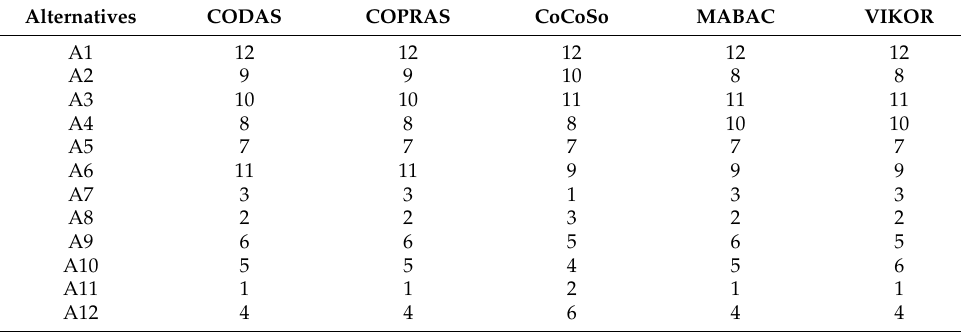
Table 13. Ranks obtained using various MCDM